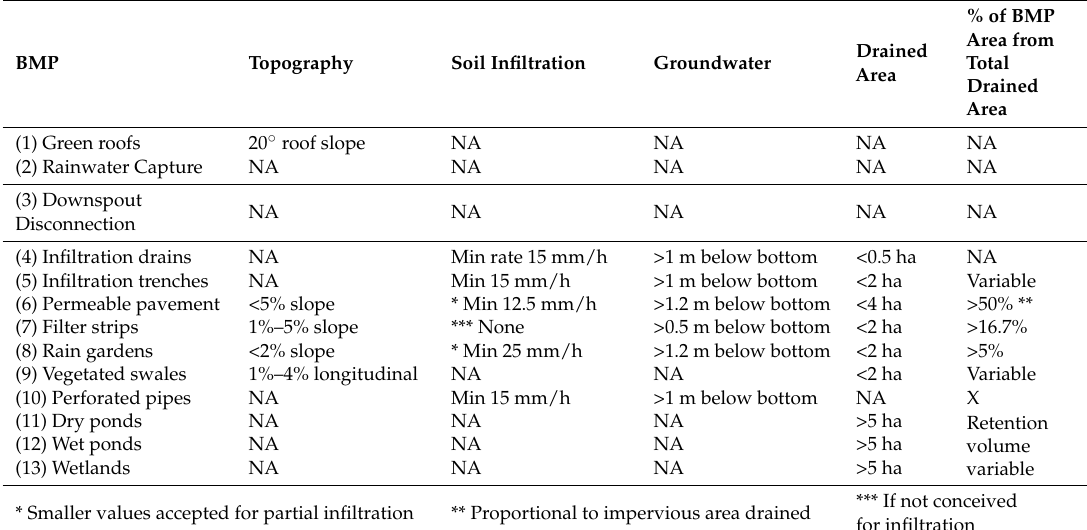
Table 1. Best Management Practices (BMPs) technical constraints